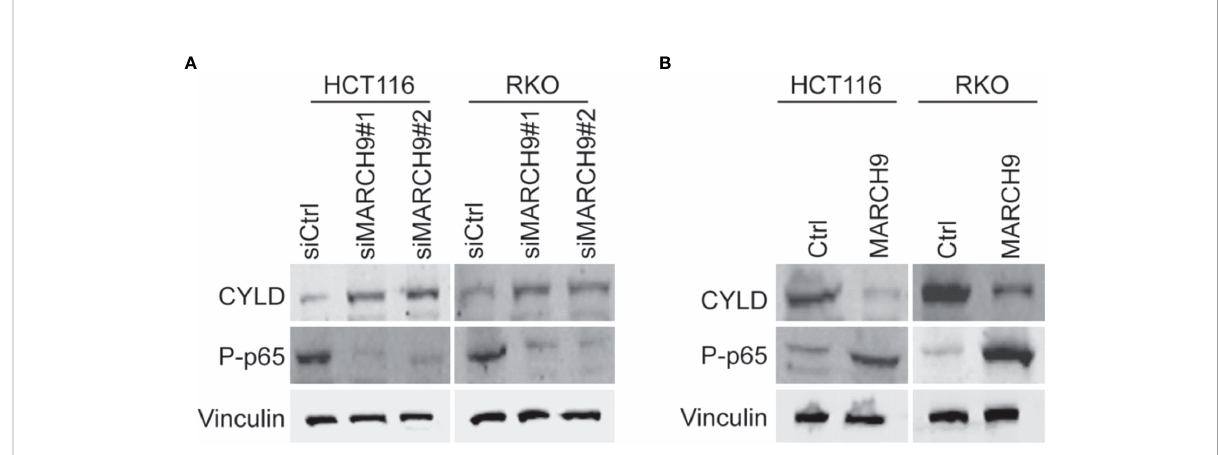
FIGURE 5 MARCH9 downregulated CYLD and activates P65. (A) Expression of CYLD, p65 and P-p65 in two CRC cell lines after MARCH9 knockdown by western blotting. (B) The expression of CYLD, p65 and P-p65 in two CRC cell lines following MARCH9 overexpression by western